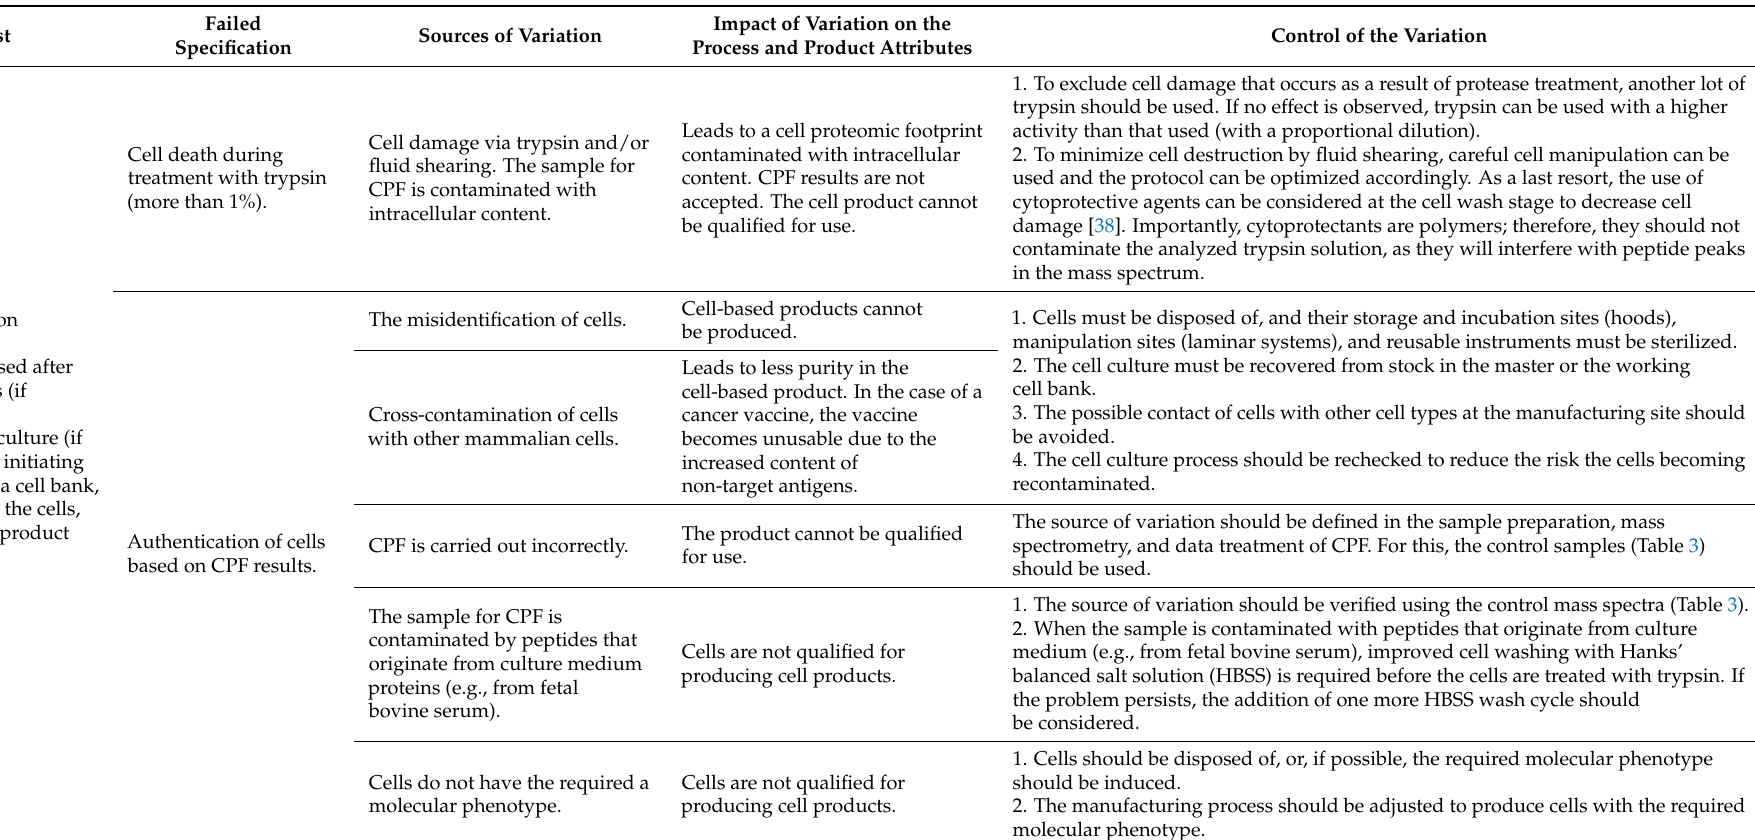
Table 4. Supplement to the quality control (QC) program to include cell proteomic footprinting (CPF) in the manufacture of cell-based immunotherapeutics (vaccines based on whole cells, cell lysates, cell membranes, and antigenic